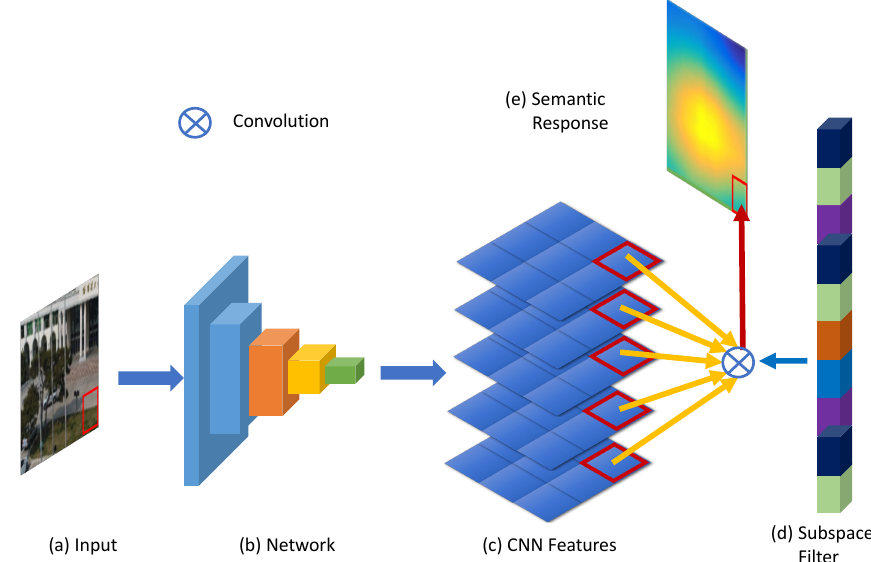
Figure 4. Semantic response. The input in ( a ) is fed into the network ( b ) to obtain the CNN features shown in ( c ). These CNN features are then convoluted by the learned subspace filter in ( d ) to generate the semantic response shown in ( e ). Here, the red bounding box illustrates the corresponding location of one single pixel in the whole operating